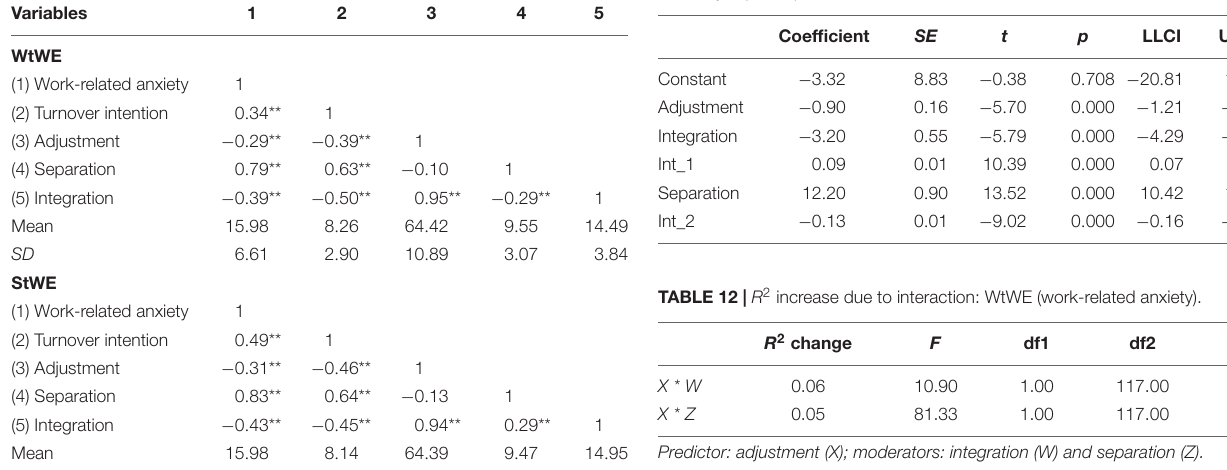
TABLE 11 | Moderation model with work-related anxiety as dependent variable for study 2 (WtWE).